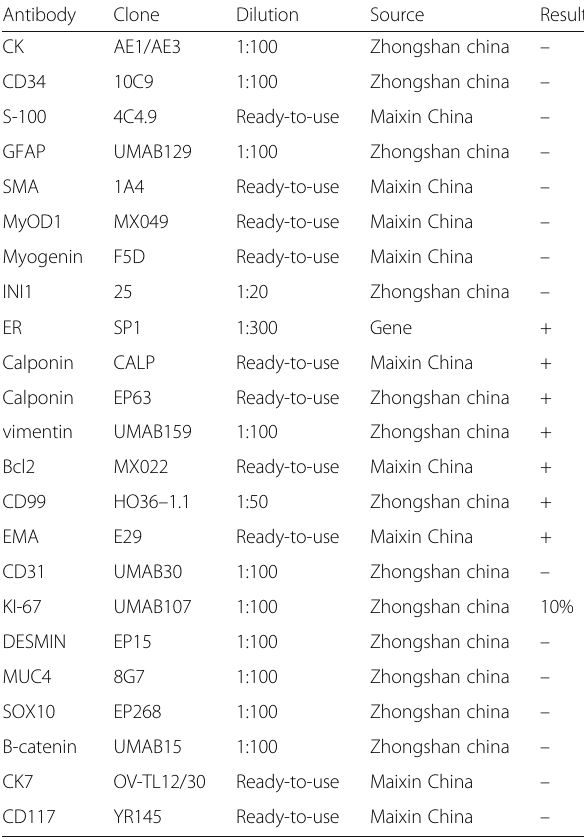
Table 1 Immunohistochemical results of myoepithelioma-like tumor of the vulvar region Antibody